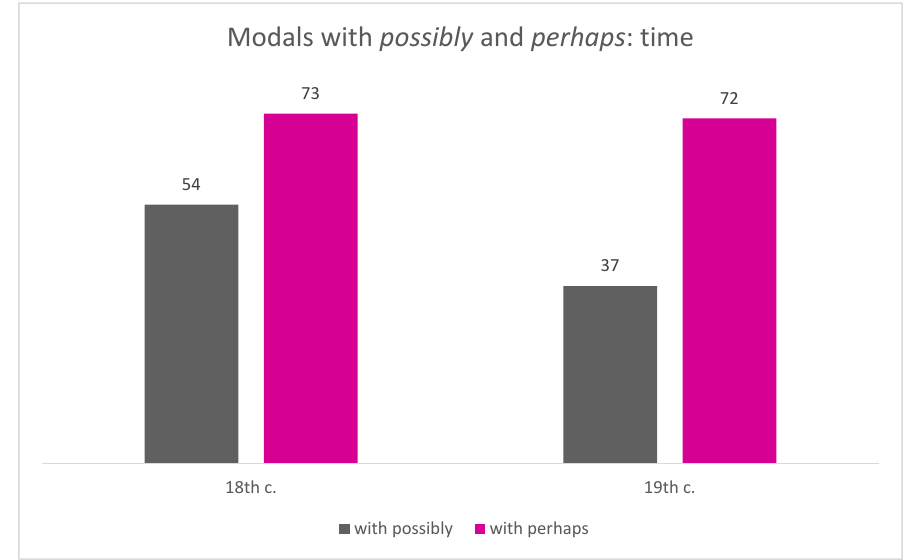
Figure 3. Distribution of adverbs with modals in time.